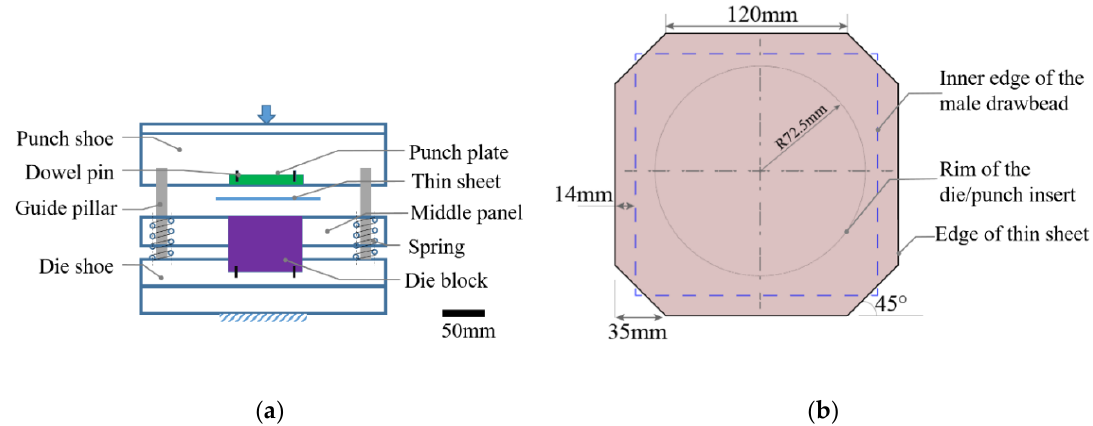
Figure 5. ( a ) Micro-stamping tool assembly ( b ) Dimensioned sample blank shape with position of the drawbead and the die/punch insert indicated.